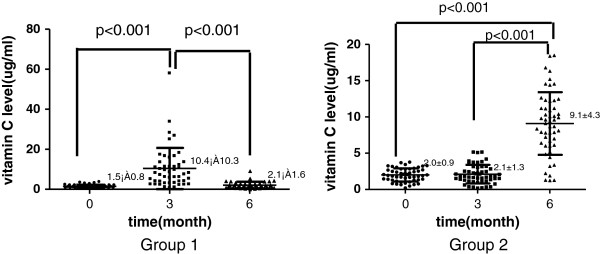
Influence of vitamin C supplementation on plasma vitamin C level. group1: patients were given oral vitamin C 200 mg per day during the first 3 months and withdraw vitamin C thereafter. group2: patients were given vitamin C during the second 3 months; vitamin C was presented as mean ± SD; levels of vitamin C were compared among groups using one-way analysis of variance (1-way-ANOVA).